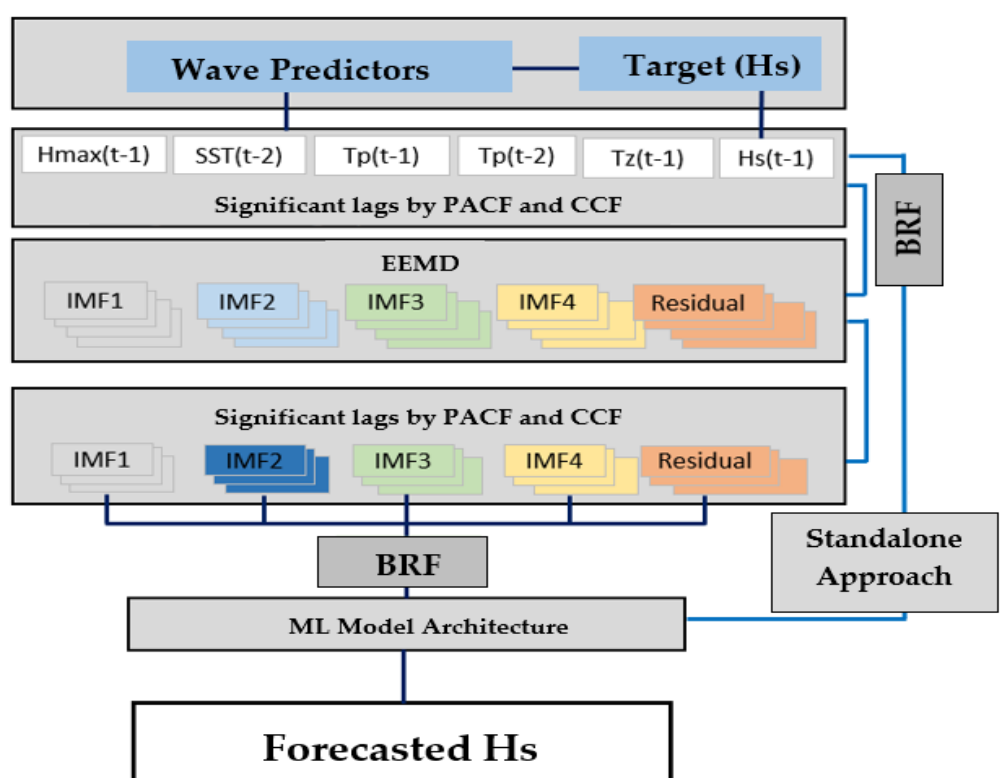
Figure 6. Workflow detailing the steps in the model designing phase, as for the proposed hybrid EEMD-BiLSTM predictive models. Note: BiLSTM = Bidirectional Long Short-Term Memory, BRF = Boruta Random Forest Optimiser.